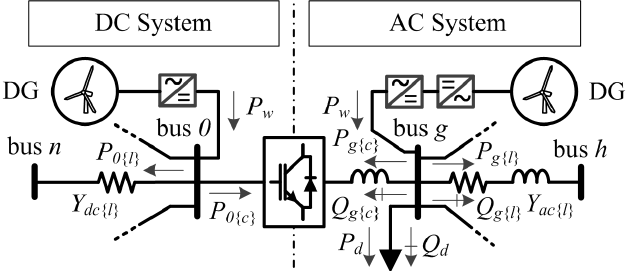
Figure 5. One feeder in the hybrid AC/DC network with the MVDC